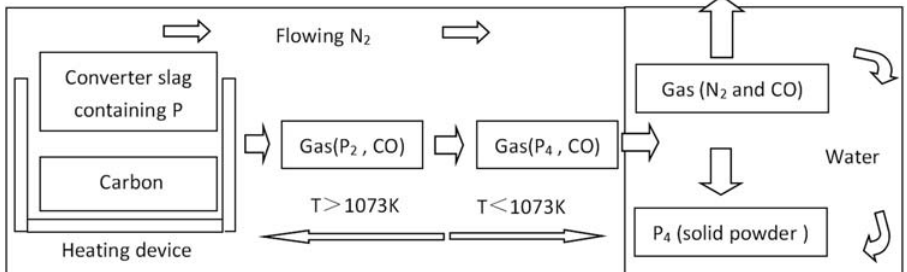
Figure 4: Cooling process of reducing gas products.